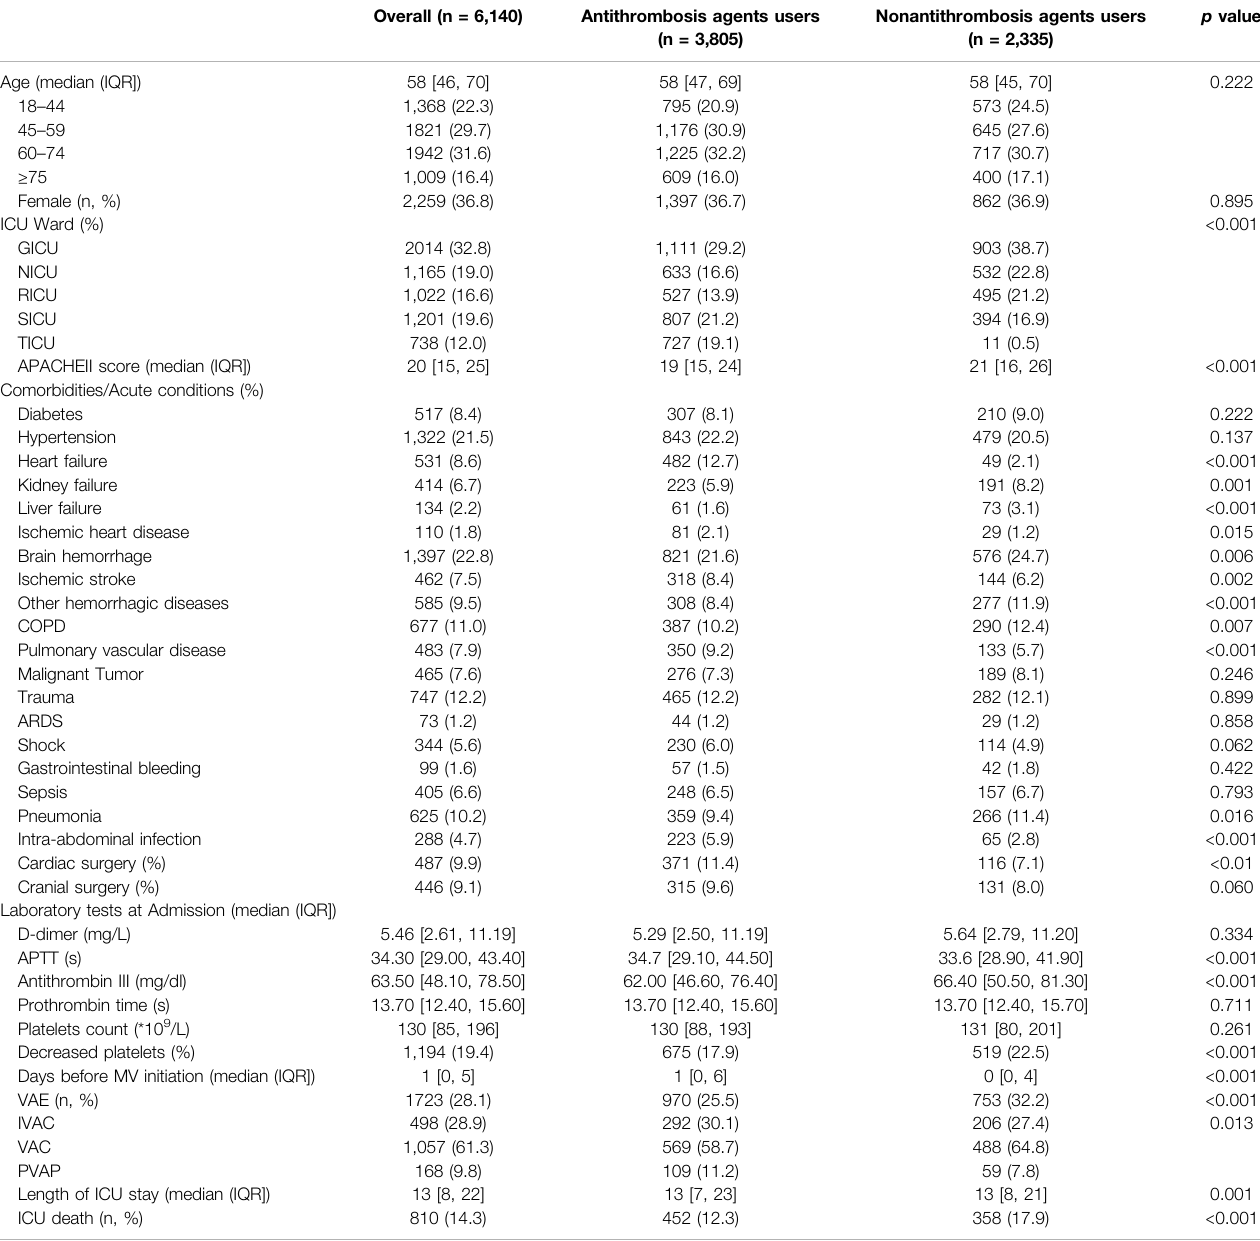
TABLE 1 | Baseline characteristics of